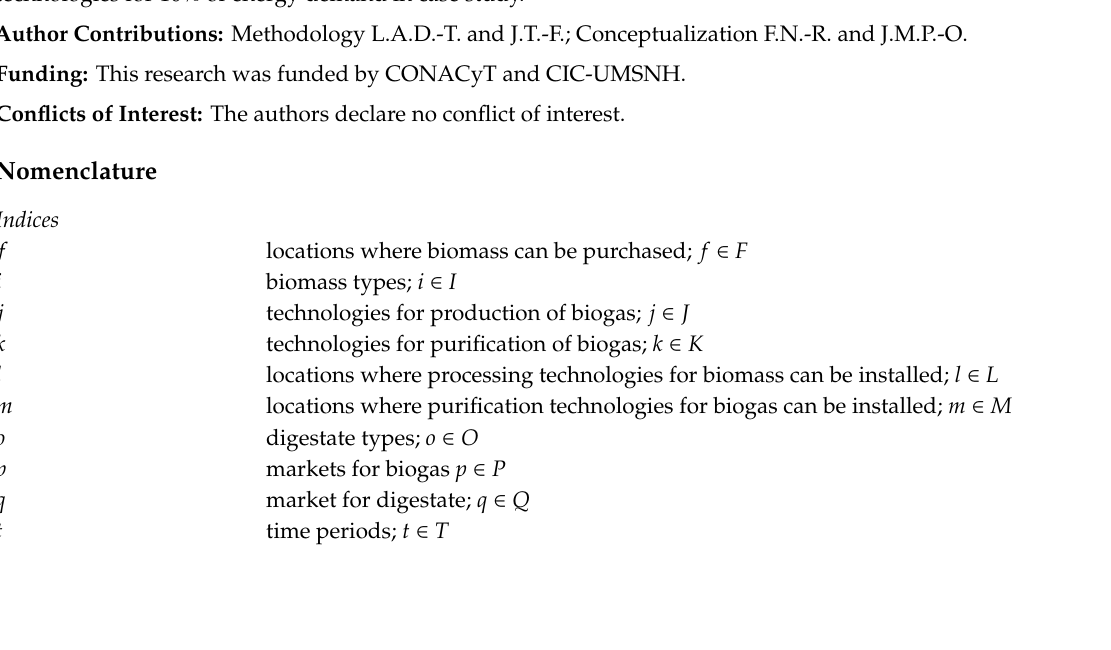
Table S1: Capacity, capital cost and yield of production technologies for biogas, Table S2: Capacity, capital cost and yield of upgrade technologies for biogas, Table S3: Economic parameters for case study, Table S4: Environmental and general parameters for case study, Table S5: Demands and availability for case study, Table S6: Selected technologies for 10% of energy demand in case